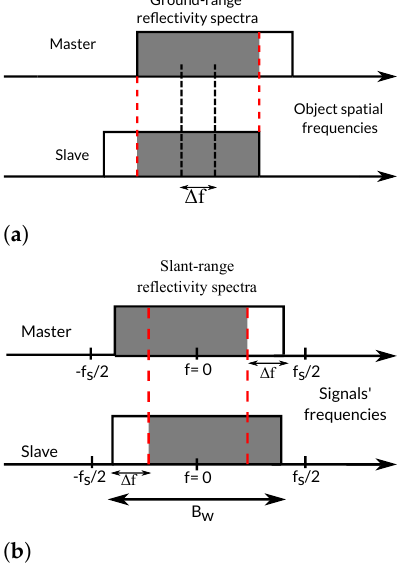
Figure 2. Illustration of the spectral shift (ground-range ( a ) and slant-range domains ( b )) between two images. Only the common band (filled in gray) contains useful interferometric